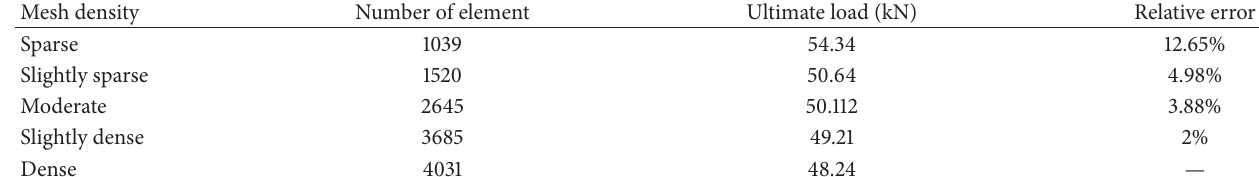
Table 3: The influence of the mesh density on bearing capacity.